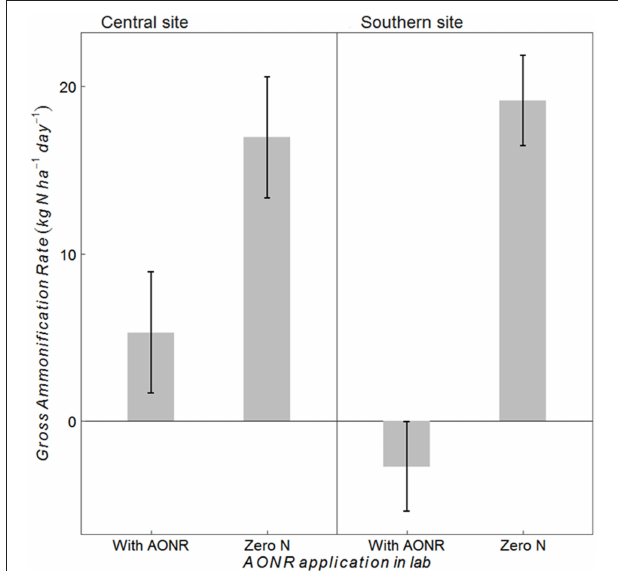
FIGURE 7 | Gross ammonification rates (kg N ha − 1 day − 1 ) in soils collected at the central and southern Iowa sites from the zero-N historical rate (1999–2014) and 2015 zero N treatment after laboratory application of N fertilizer at the agronomic optimum N rate (AONR) to test hypothesis iv vs. v ( Table 1 ) under similar soil moisture and temperature conditions to avoid indirect ecological effects. Vertical bars represent 95% confidence interval.